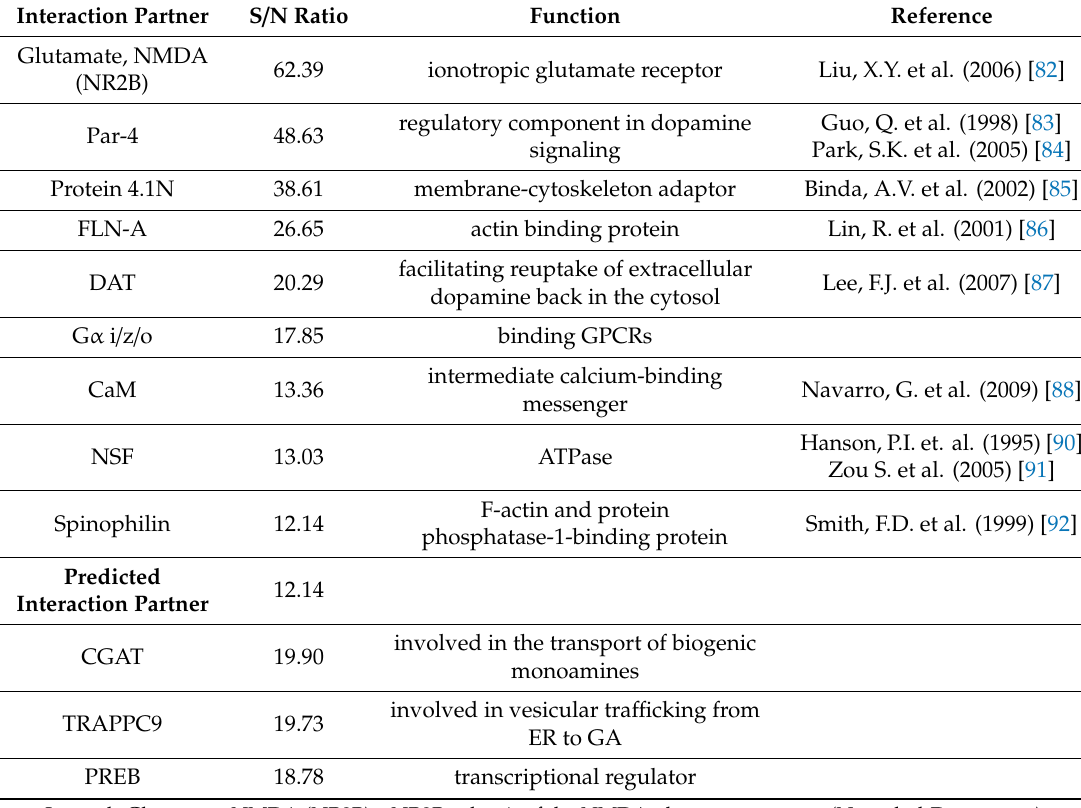
Table 2. The bioinformatics approach-informational spectrum method (ISM) analysis of interaction partners of the third cytoplasmic loop (ICL3) of the D 2 -R. A lower signal to noise S / N ratio suggests a lower interaction a ffi nity between tested protein